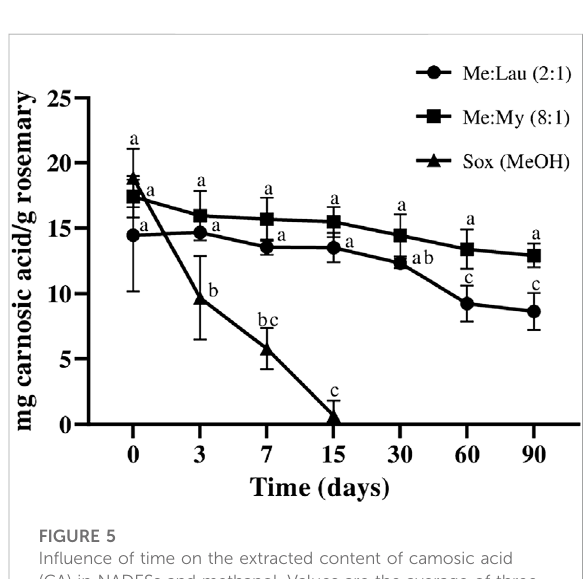
FIGURE 5 In fl uence of time on the extracted content of camosic acid (CA) in NADESs and methanol. Values are the average of three independent extracts replicates ±SD based on triplicate values. Statistically signi fi cant differences between the time points in each system are represented by letters. Different letters indicate signi fi cant differences within each system.